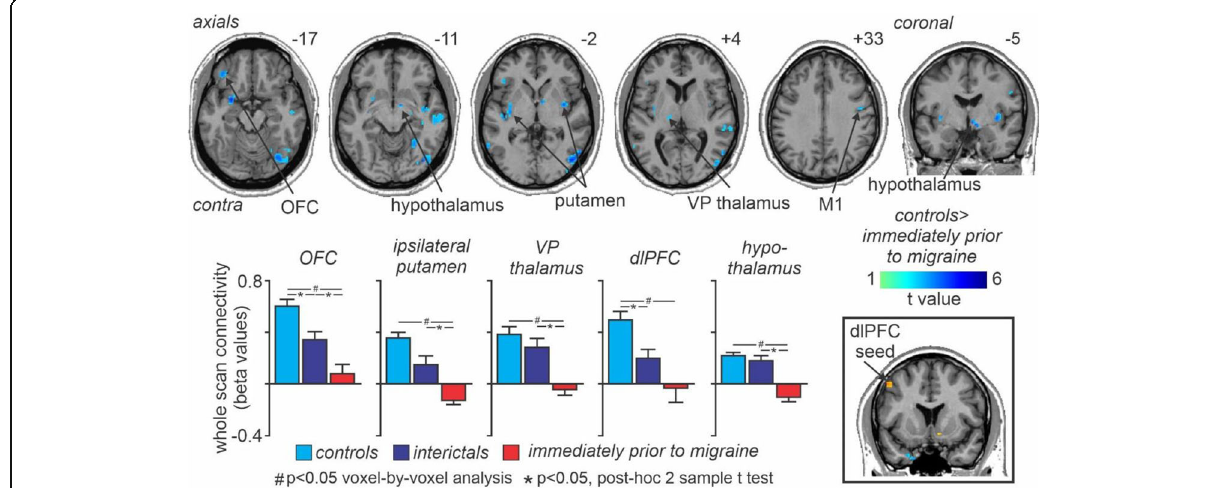
Fig. 4 Whole scan connectivity: Significant differences in contralateral dorsolateral prefrontal cortex (dlPFC) whole scan connectivity between controls and migraineurs in the period immediately prior to a migraine headache. Significant clusters are overlaid onto a mean T1-weighted anatomical image. Slice locations in Montreal Neurological Institute space are indicated to the top right of each slice. The dlPFC seed is shown in the lower right inset. Note that connectivity strengths were significantly reduced in a number of brain regions including the orbitofrontal cortex (OFC), putamen, ventroposterior (VP) thalamus, primary motor cortex (M1) and the hypothalamus. Plots of mean (±SEM) beta values (effect sizes) revealed that whole scan connectivity values decreased significantly in migraineurs only during the 24-h period immediately prior to migraine, that is, they were not different between controls and migraineurs during the interictal phase. Beta values indicate the strength of functional connectivity between the dlPFC and respective brain